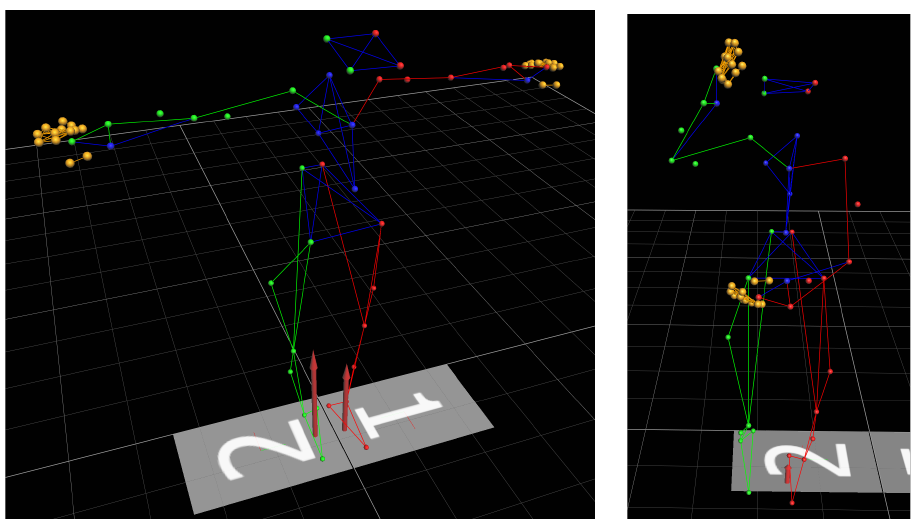
Figure 3. Model of the dancer after post-processing T-pose (on the left ) and while performing the dance (on the right